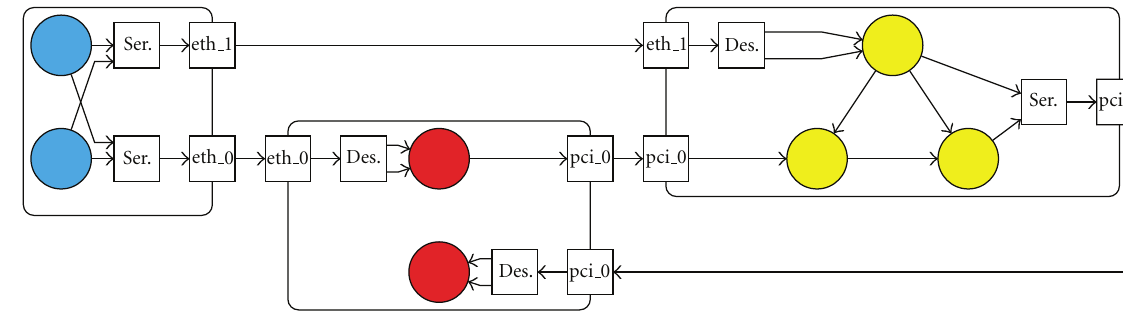
Figure 7: Communication refinement of the input application